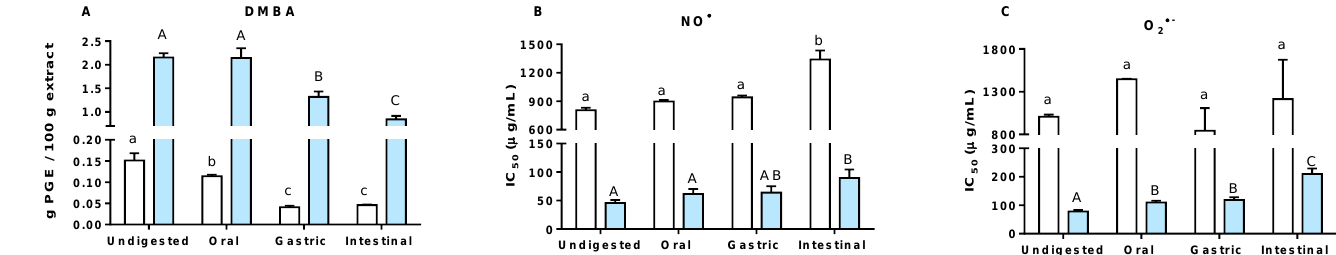
Figure 2. Effect of gastrointestinal digestion on the total phlorotannin content ( A ) NO • radical scavenging ( B ) and O 2 •− radical scavenging ( C ) activities of CRD (white bars) and EtOAc (blue bars) extracts from H. elongata . Different letters (a–c) indicate significant differences between means of the white bars ( p < 0.05). Different capital letters (A–C) indicate significant differences between means of the blue bars ( p < 0.05).